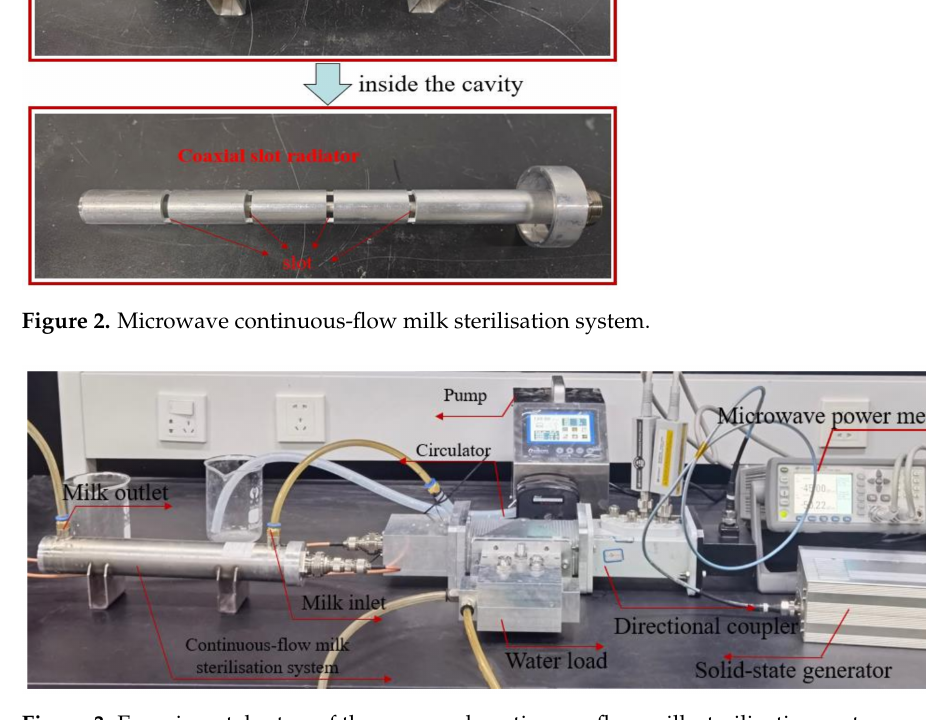
Figure 3. Experimental setup of the proposed continuous-flow milk sterilization system. The microwave frequency was set to 2.45 GHz. Full-fat milk (Mengniu Dairy Co., Ltd., Tangshan, China) was heated. Parameter S11 of the continuous-flow system with different variation of coaxial slot radiator rotation angles were measured using a vector network. The results are shown in Figure